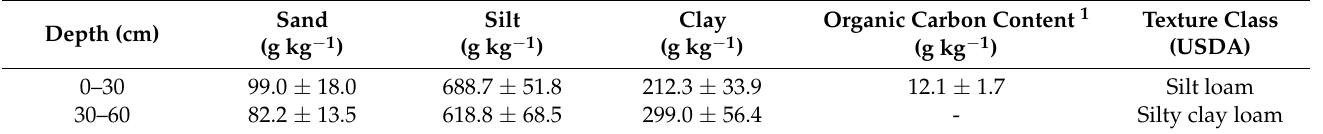
Table 1. Average soil texture and organic carbon content ± standard deviation and the resulting texture class (USDA) for the depth intervals 0–30 cm and 30–60 cm ( n = 3). The organic carbon content of the upper subsoil (30–60 cm) was not